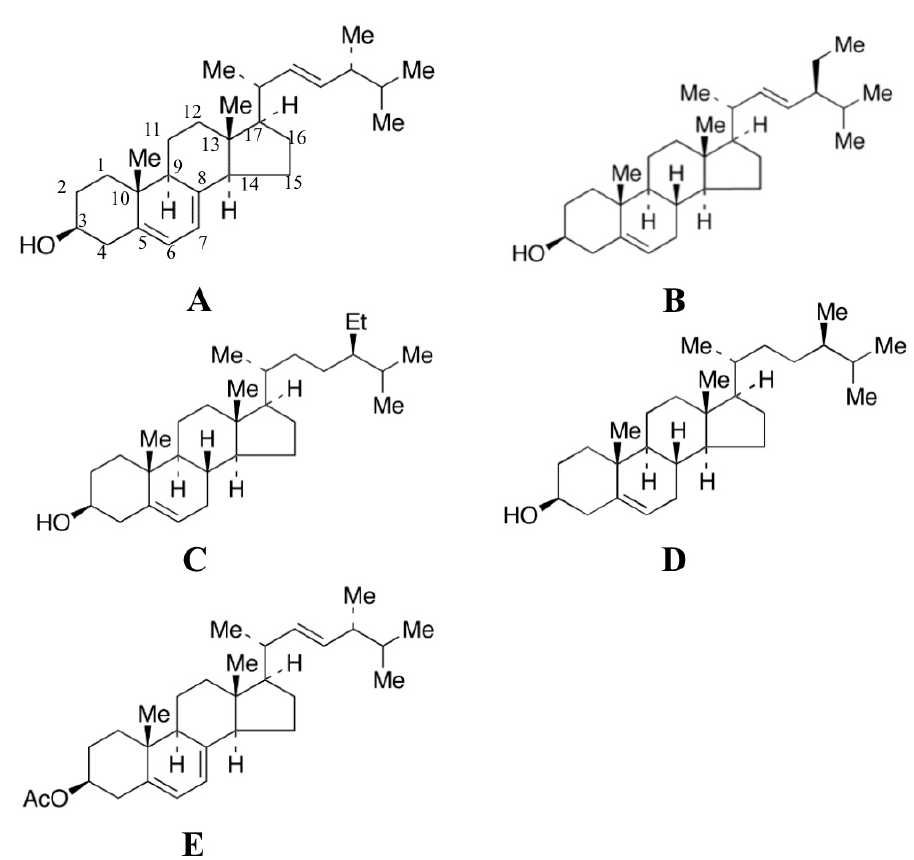
Figure 1. The structure of tested phytosterol compounds: ( A ) ergosterol; ( B ) stigmasterol; ( C ) β - sitosterol; ( D ) campesterol; ( E ) ergosterol